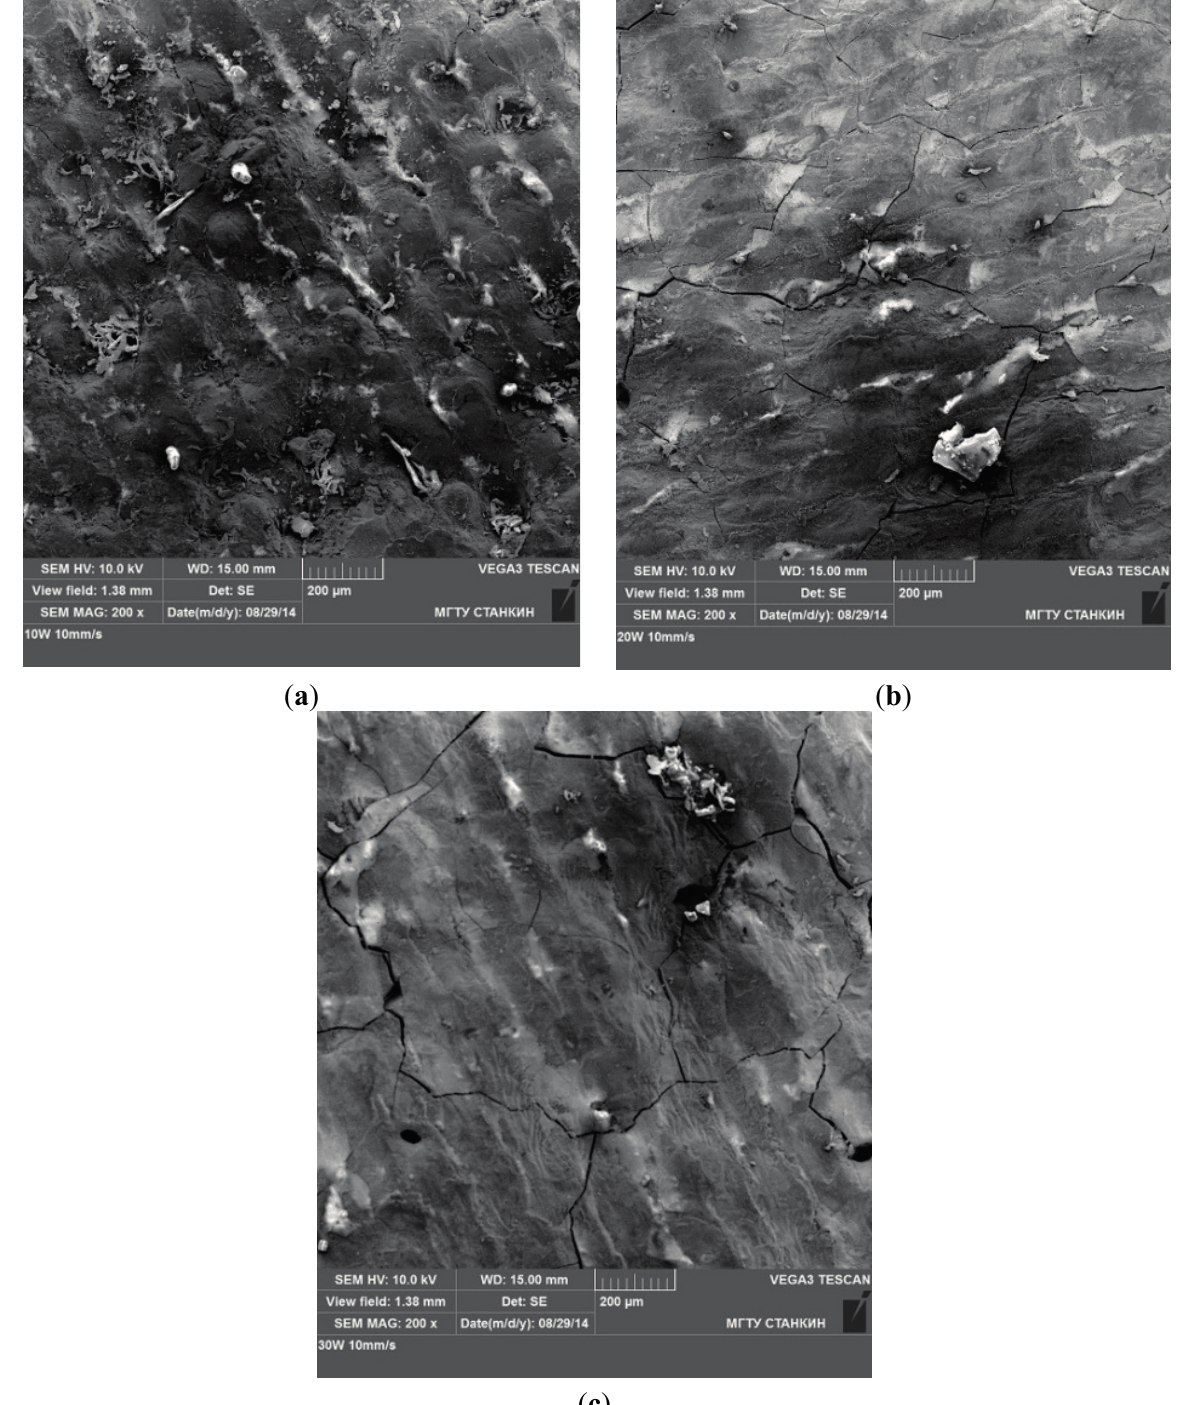
Figure 3. SEM image of laser treatment surface after the CCDS with the scan velocity 10 mm/s: ( a ) P = 10 W; ( b ) P = 20 W; and ( c ) P = 30